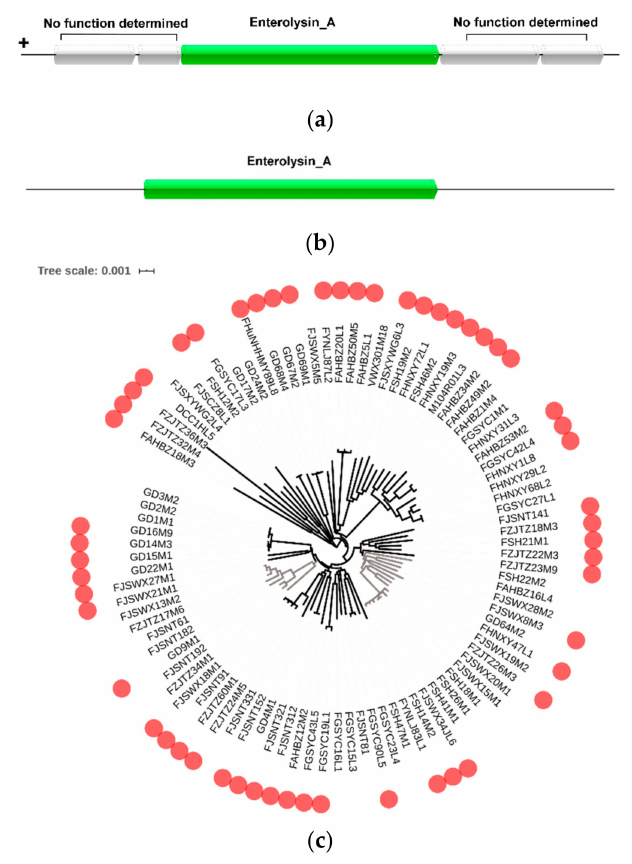
Figure 5. Prediction of bacteriocin operon in L. mucosae : ( a ) Predicted gene cluster for enterolysin A synthesis in most strains of L. mucosae . ( b ) Predicted gene cluster for enterolysin A synthesis in the strain DCC1HL5. ( c ) Distribution of complete bacteriocin